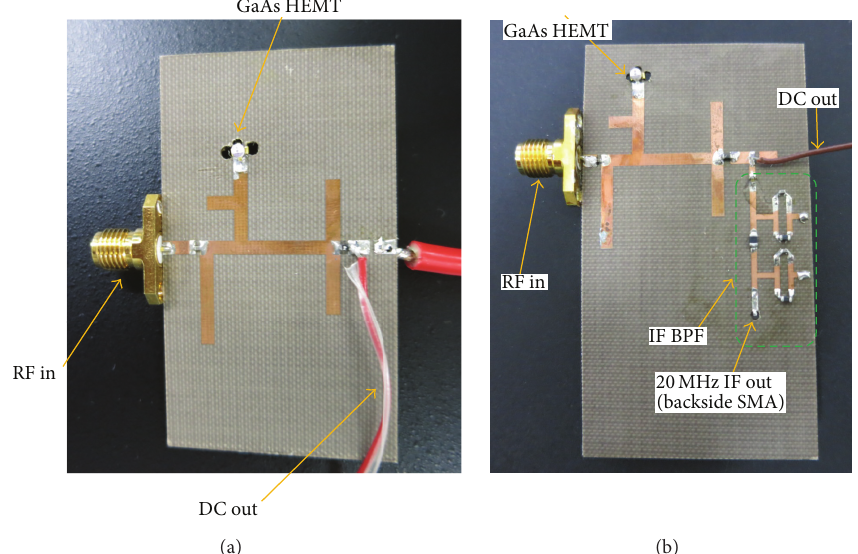
Figure 4: Fabricated C-band rectifier: (a) without BPF and (b) with BPF.